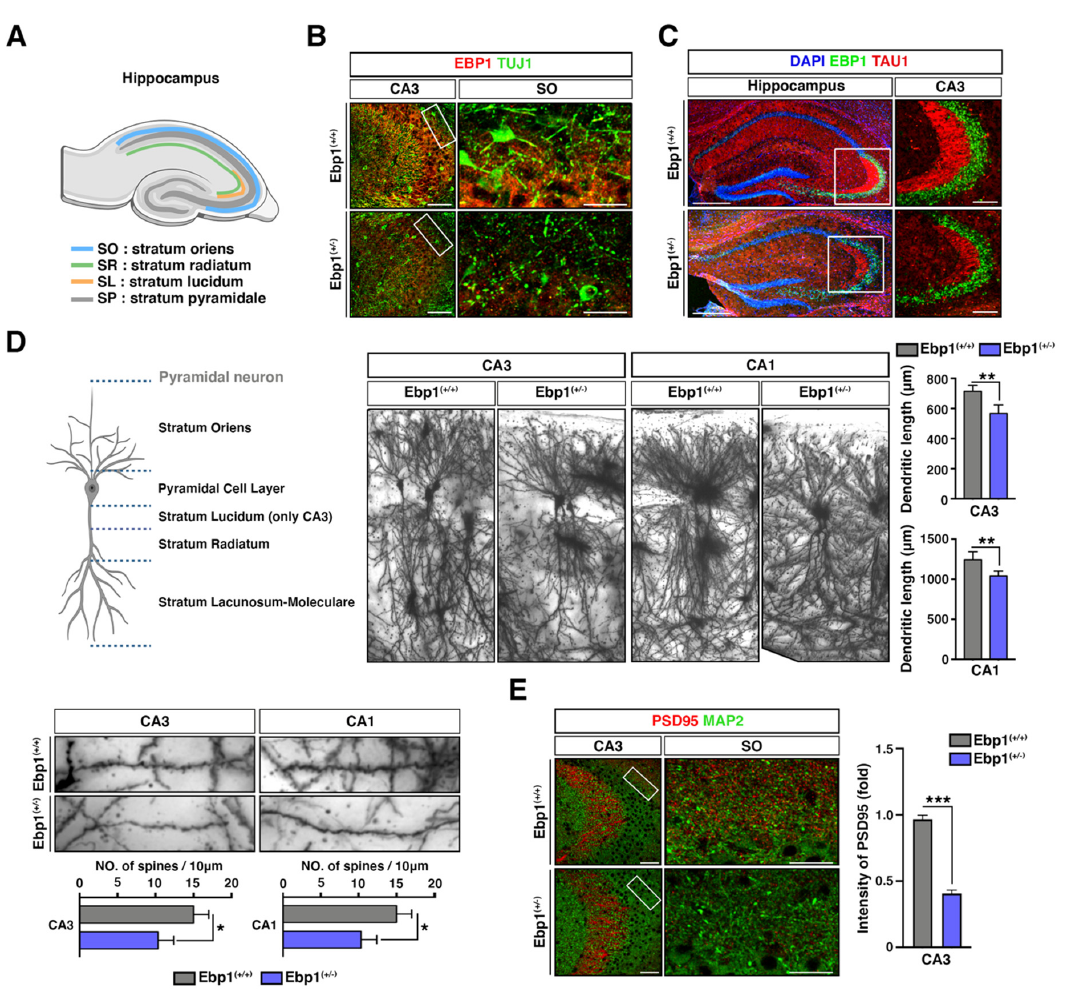
Figure 2. Ebp1 ( +/ − ) mice displayed impaired neural development in stratum oriens (SO) of CA3 / 2 region in hippocampus. ( A ) representative hippocampus structure is displayed. Created with BioRender. ( B ) WT and Ebp1 heterozygous mouse brain were isolated and subjected to IHC staining with anti-EBP1 and TUJ1 antibodies, early neuronal markers. CA3 region and cropped specific region as SO are shown. Scale bar: 200 µ m. ( C ) Brain tissues were isolated from Ebp1 WT and heterozygous mice and subjected to IHC analysis. The hippocampus was stained with anti-EBP1 (green) and TAU1 (red, axon specific marker) antibodies. The right-hand panel shows higher magnification of the CA3 region of the hippocampus; corresponding SO region is indicated by a white box. Intensity of Tau1 positive signals were quantified and displayed as bar graphs (right). Scale bar: 200 µ m. ( D ) Fresh mouse brain tissues were stained with Golgi-Cox stain. Golgi-stained CA1 and CA3 hippocampal neurons (upper right) and their dendritic processes (bottom left) are shown, respectively. Total dendritic length was measured using image J. Dendrite numbers in the SO region of pyramidal neurons were counted within every 10 µ m. * p < 0.05, ** p < 0.01. Created with BioRender. ( E ) Brain tissues, isolated from Ebp1 ( +/+ ) and Ebp1 ( +/ − ) mice, were stained with anti-PSD95 (red, marker for post-synapse) and MAP2 (green, marker for dendrites) antibodies. High power images show PSD95 and MAP2 double-labeling in the CA3 and corresponding SO regions (left). The intensity of PSD95 was quantified and shown as a bar graphs (right). *** p < 0.001. Scale bar: 200 μ m. All data are shown as the mean ± s.e.m.